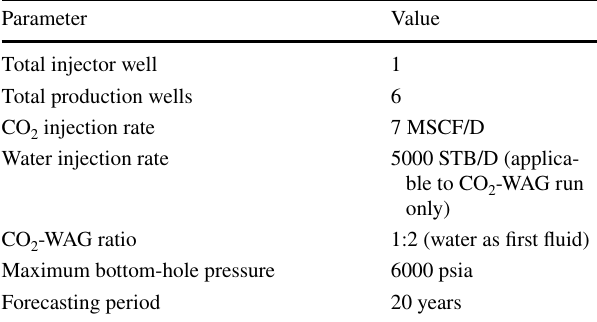
Table 13 Constraints used to run CCO